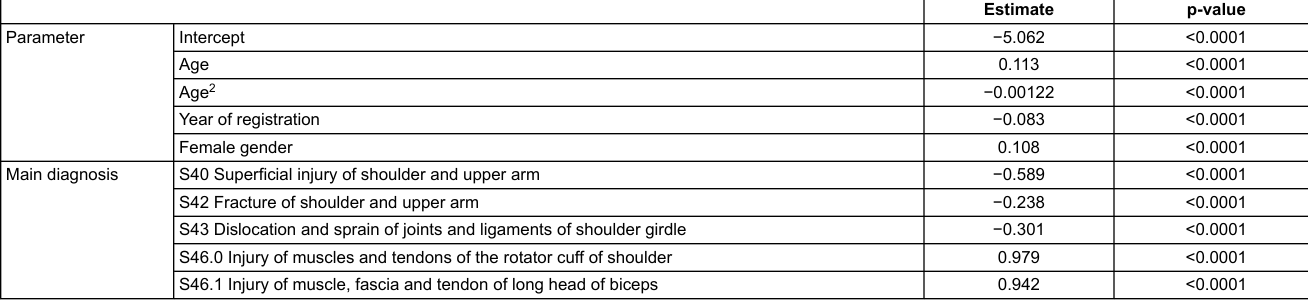
Table S1: Logistic regression estimates for age, gender, year of registration and main diagnosis from a model for the risk to develop a frozen shoulder complication.